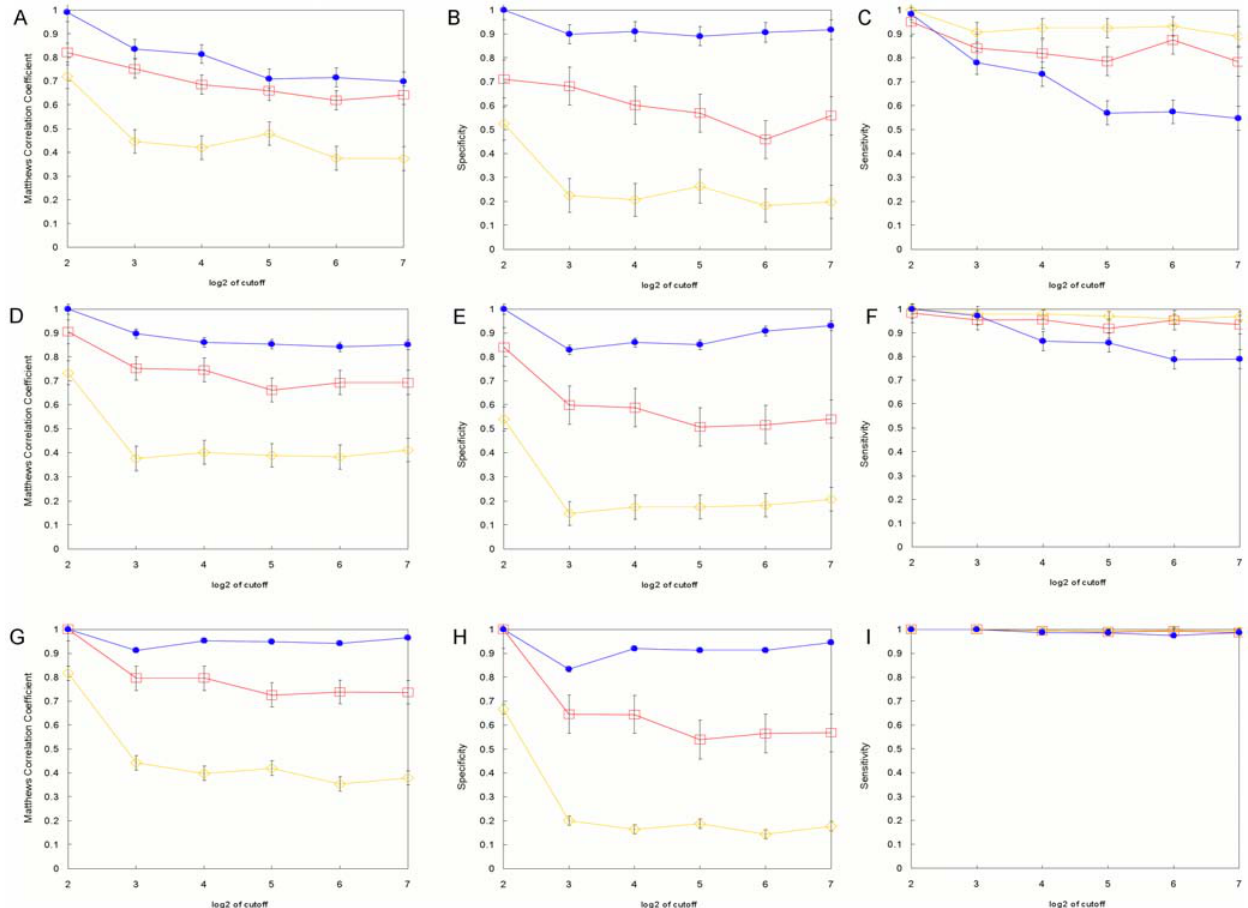
Figure 3. Performance of the position weight matrix models with step-function sampling. A–C. Alignments containing 20 sites. D–F. Alignments containing 50 sites. G–I. Alignments containing 200 sites. The log-odds, Match, and quadratic programming results are denoted by the red open-square, yellow open-diamond, and blue filled-oval markers respectively. Each data point is the mean of five replicates. Error bars denote the standard deviation of the mean.